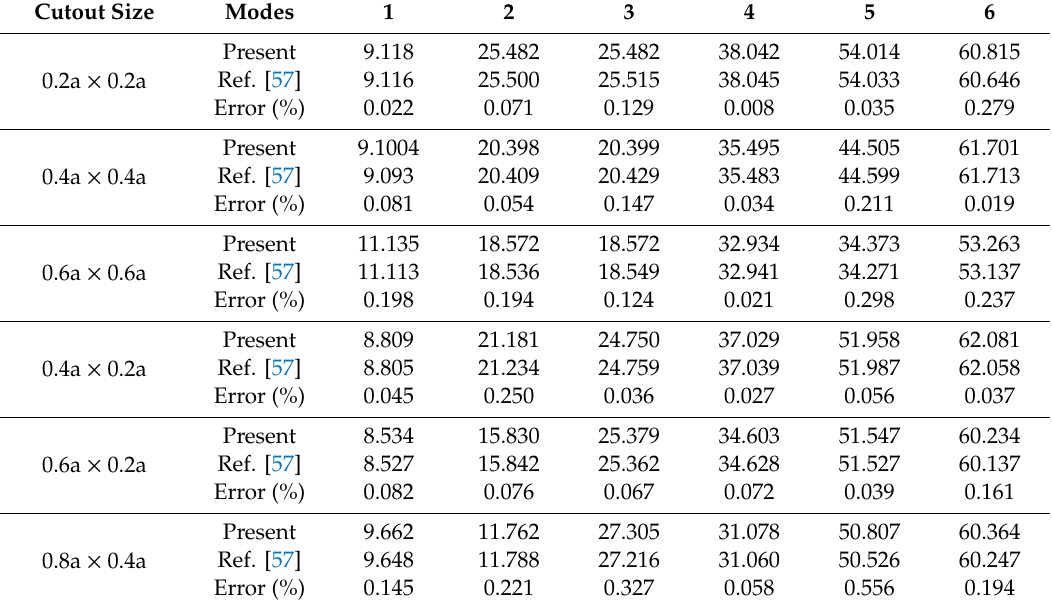
Table 4. First six frequency parameters Ω of cross-ply (0 ◦ / 90 ◦ ) laminated square plate with di ff erent cutout sizes under simply supported boundary